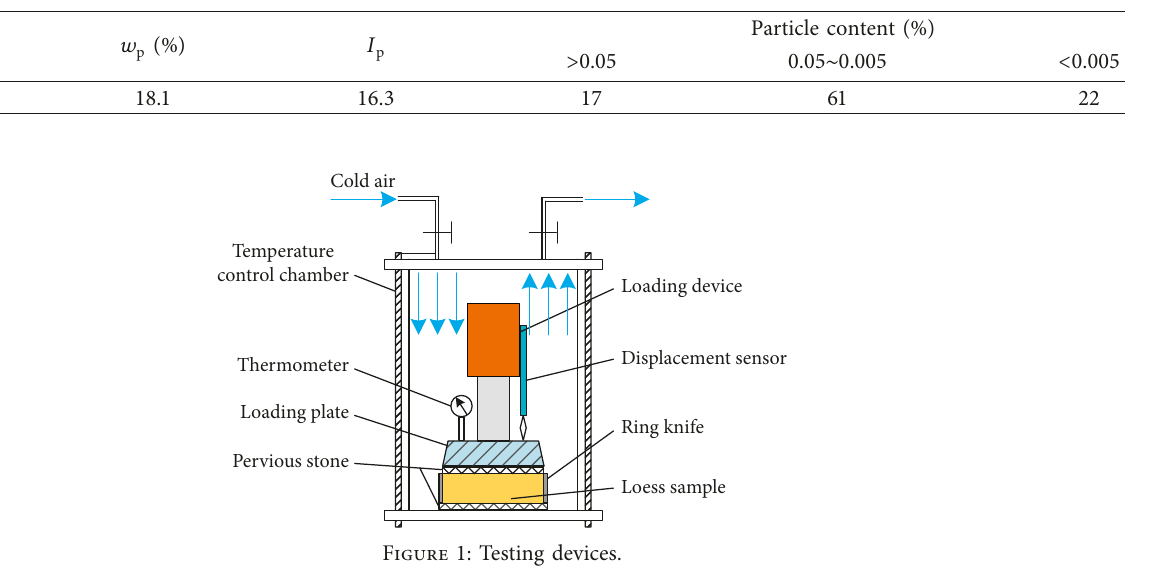
Table 1: Physical properties of loess.